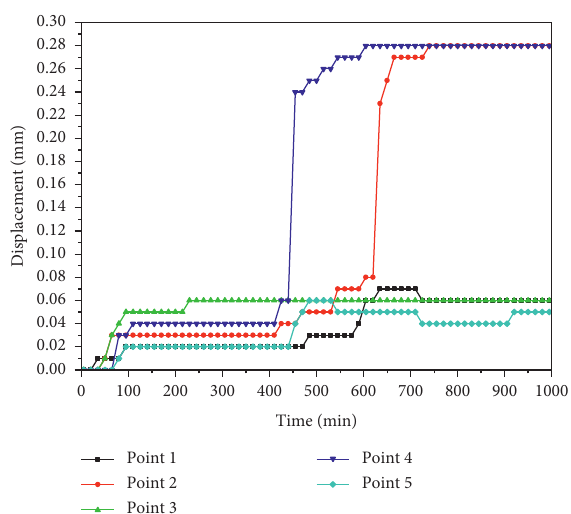
Figure 6: Displacement duration curve of L3 section in excavation scheme